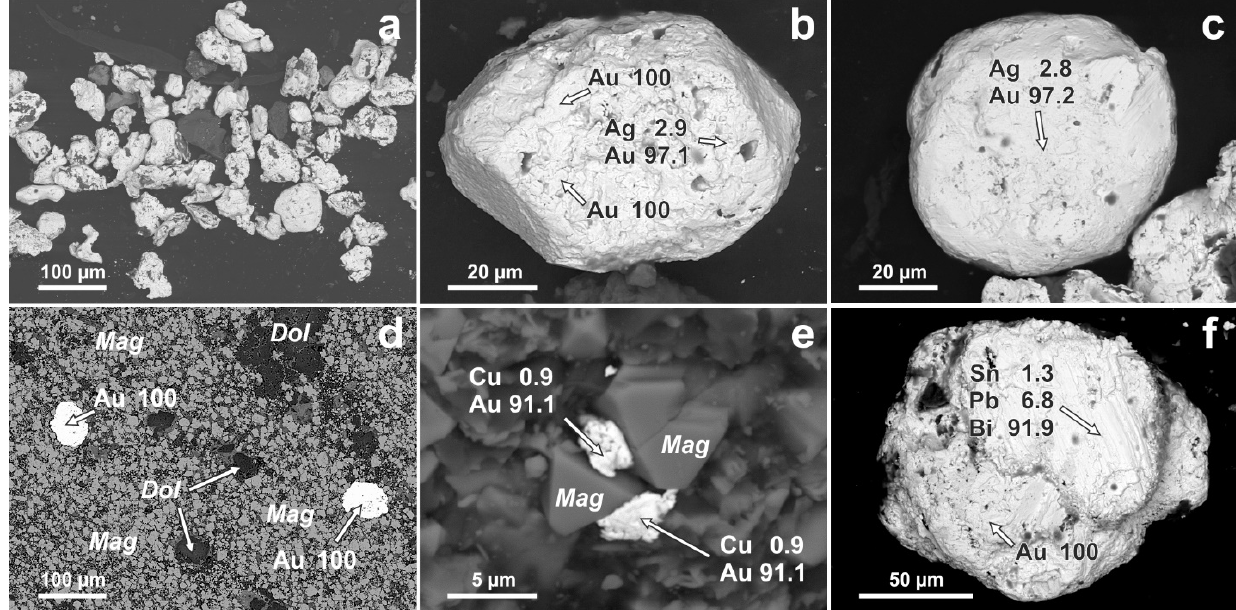
Figure 9. Gold-silver alloys and associated minerals in ores and explosive breccia from the Poperechnoye deposit: ( a – c )— high purity gold of variable shape ( a ), subhedral (with retained crystal faces) ( b ) and rounded ( c ); ( d , e )—gold grains in magnetite ore; ( f )—native bismuth overgrowth on gold grain. Chemical analyses of alloys and minerals in all figures are in wt.%. Arrows indicate precise location of SEM-EDS data